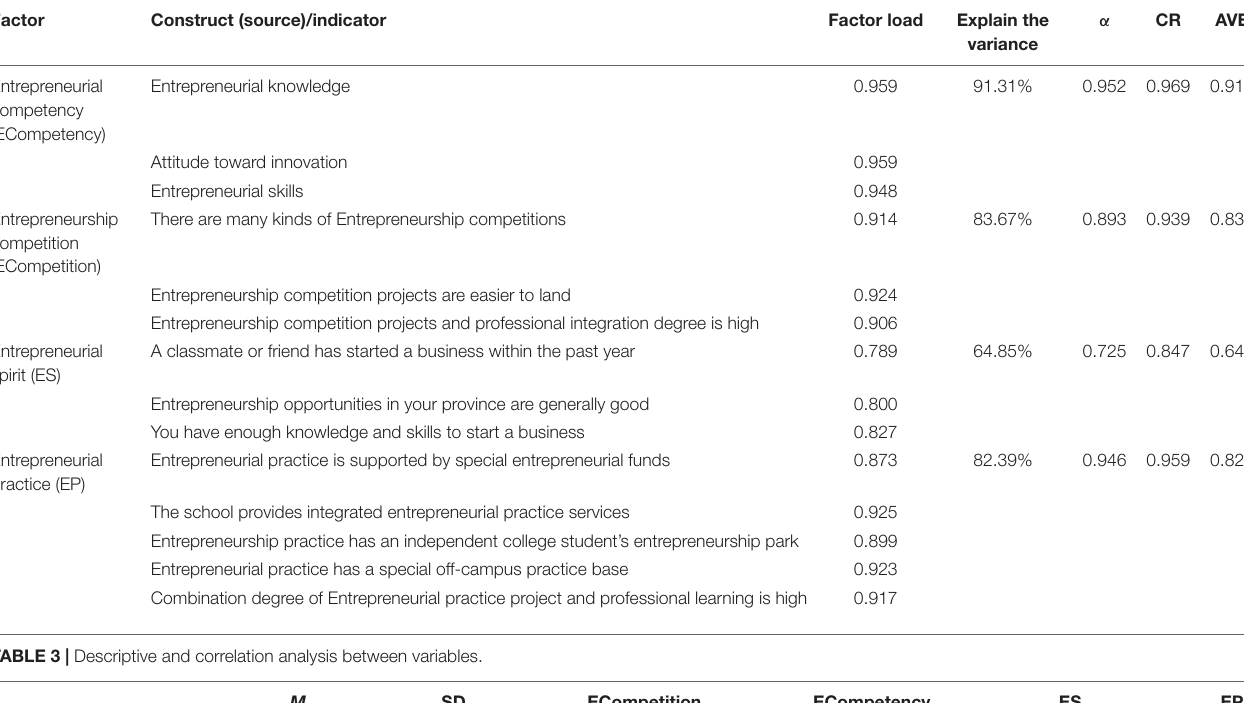
TABLE 2 | Reliability and validity tests.